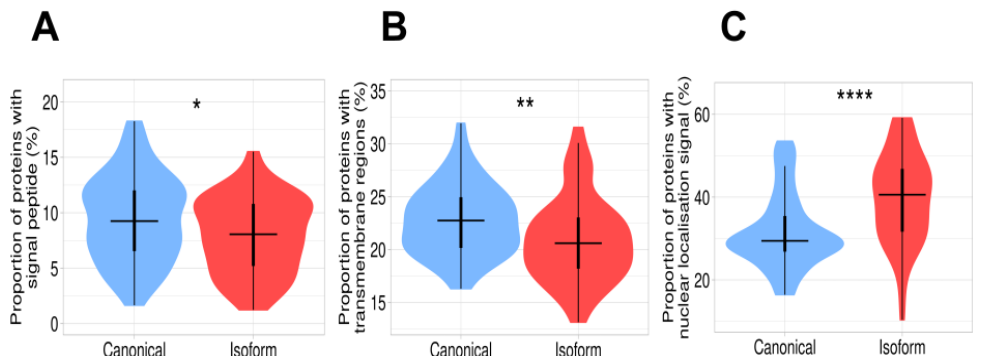
Figure 3. Difference in subcellular localization between canonical proteins and isoforms. ( A ) Proportion of proteins containing signal peptides. This value is significantly higher in canonical proteins than in isoforms. ( B ) Proportion of proteins containing transmembrane regions. The plot demonstrates a significant decrease in transmembrane proteins in the isoform set. ( C ) Proportion of proteins with nuclear localization signal. Isoforms have a remarkably high proportion of nuclear localization signals in comparison with canonical proteins. Signes *, **, **** mean significant differences with p-value < 0.05, p-value < 0.01, and p-value < 0.0001, respectively.